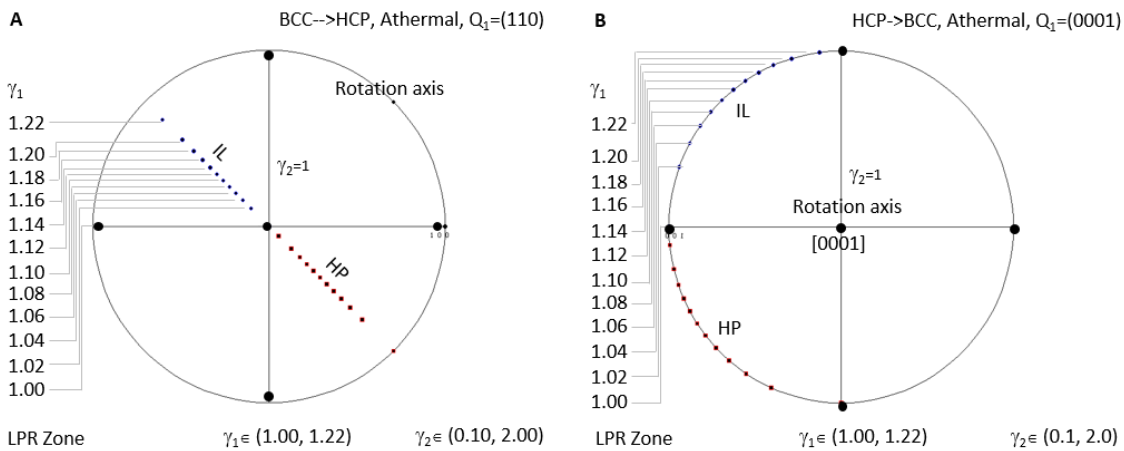
Figure 8. Stereographic project showing calculated crystallographic features (HP and IL) of athermal precipitation in HCP–BCC system. ( A ) BCC-to-HCP LPR zone under the condition of non-inclined vector Q 1 parallel to the close-packed plane (110). ( B ) HCP-to-BCC athermal LPR zone under the condition of non-inclined vector Q 1 parallel to basal plane (0001).